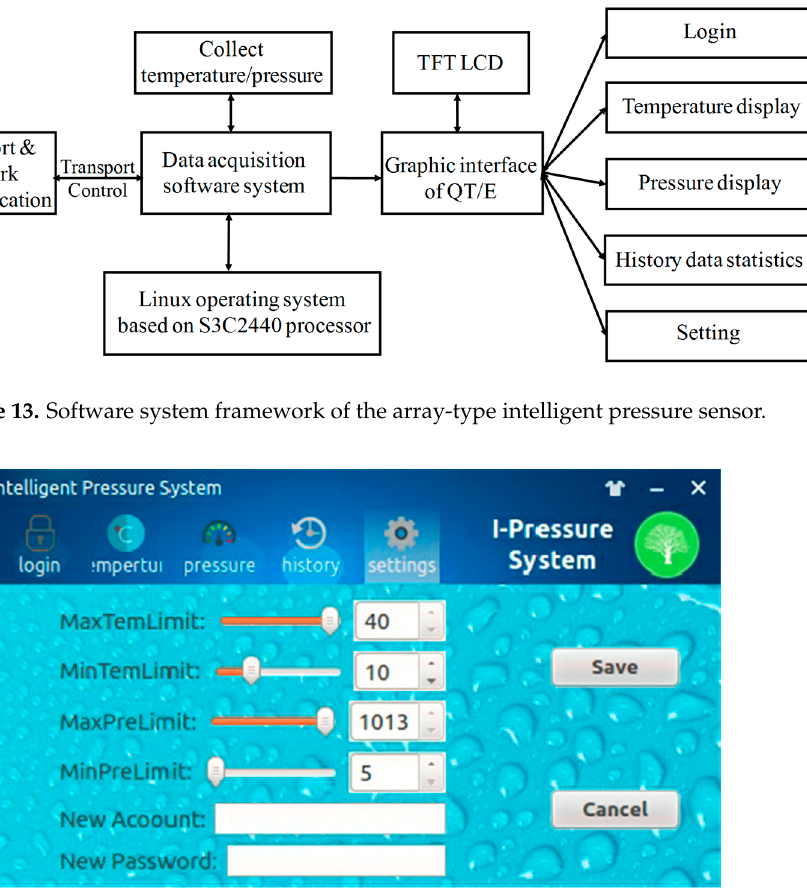
Figure 14. Graphical user interface for human-computer interaction.